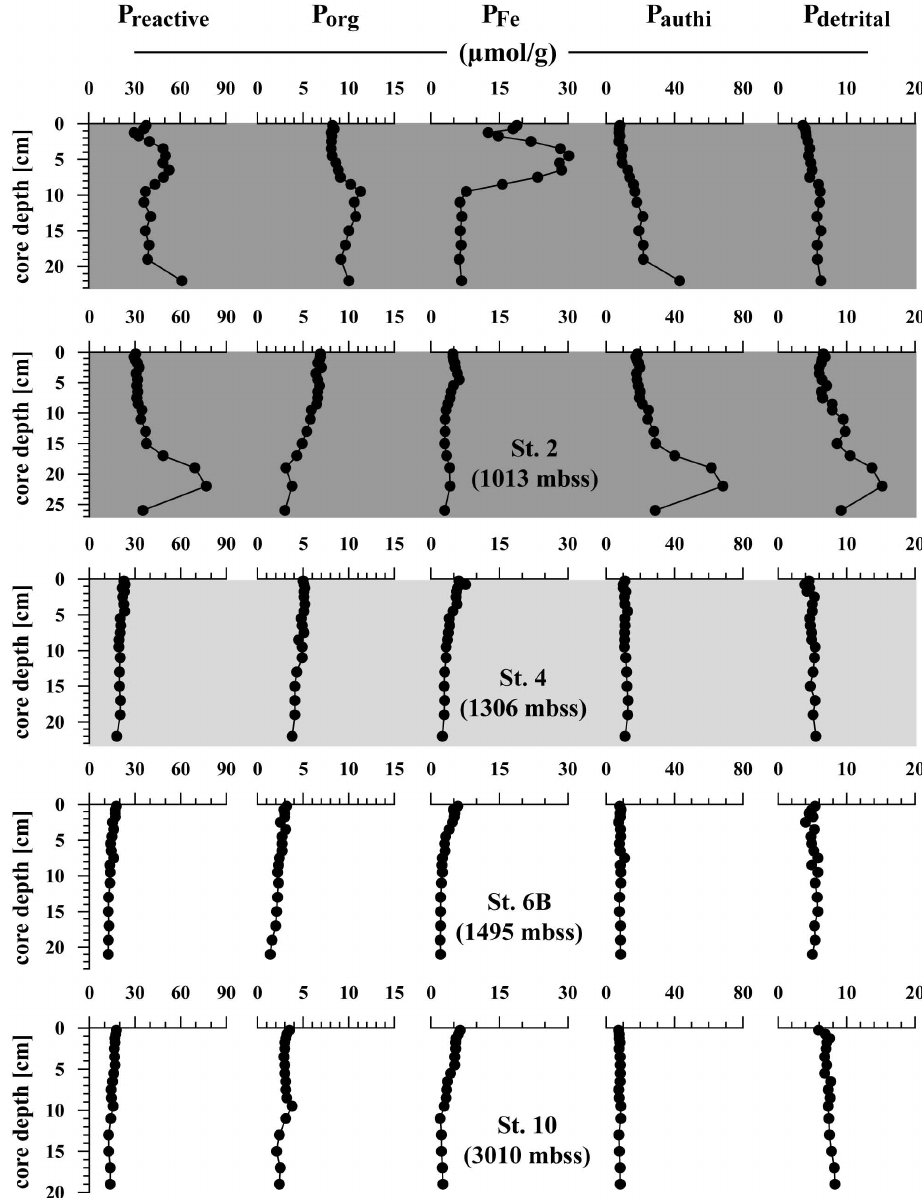
Fig. 5. Phosphorus speciation in the cores from stations 1B, 2, 4, 6B and 10 as determined by sequential extraction: total reactive P (P reactive ) calculated as total P - detrital P, Fe-bound P (P Fe ) , authigenic Ca-P (P authi ) , detrital P (P det ) , and organic P (P org ) . Exchangeable P was negligible in all cores and is therefore not shown. Fill colours indicate station position as detailed in the caption to Fig.